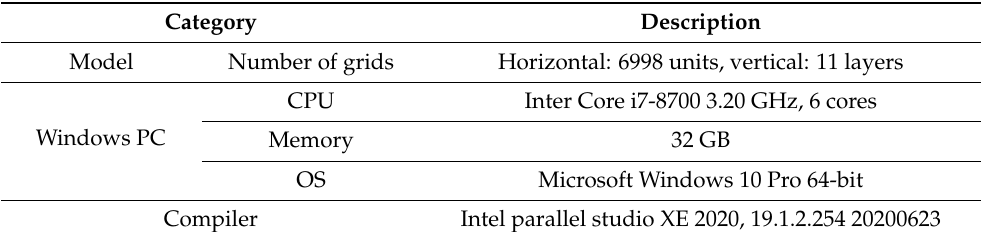
Table 3. Model and computer specifications used for the evaluation of the parallel